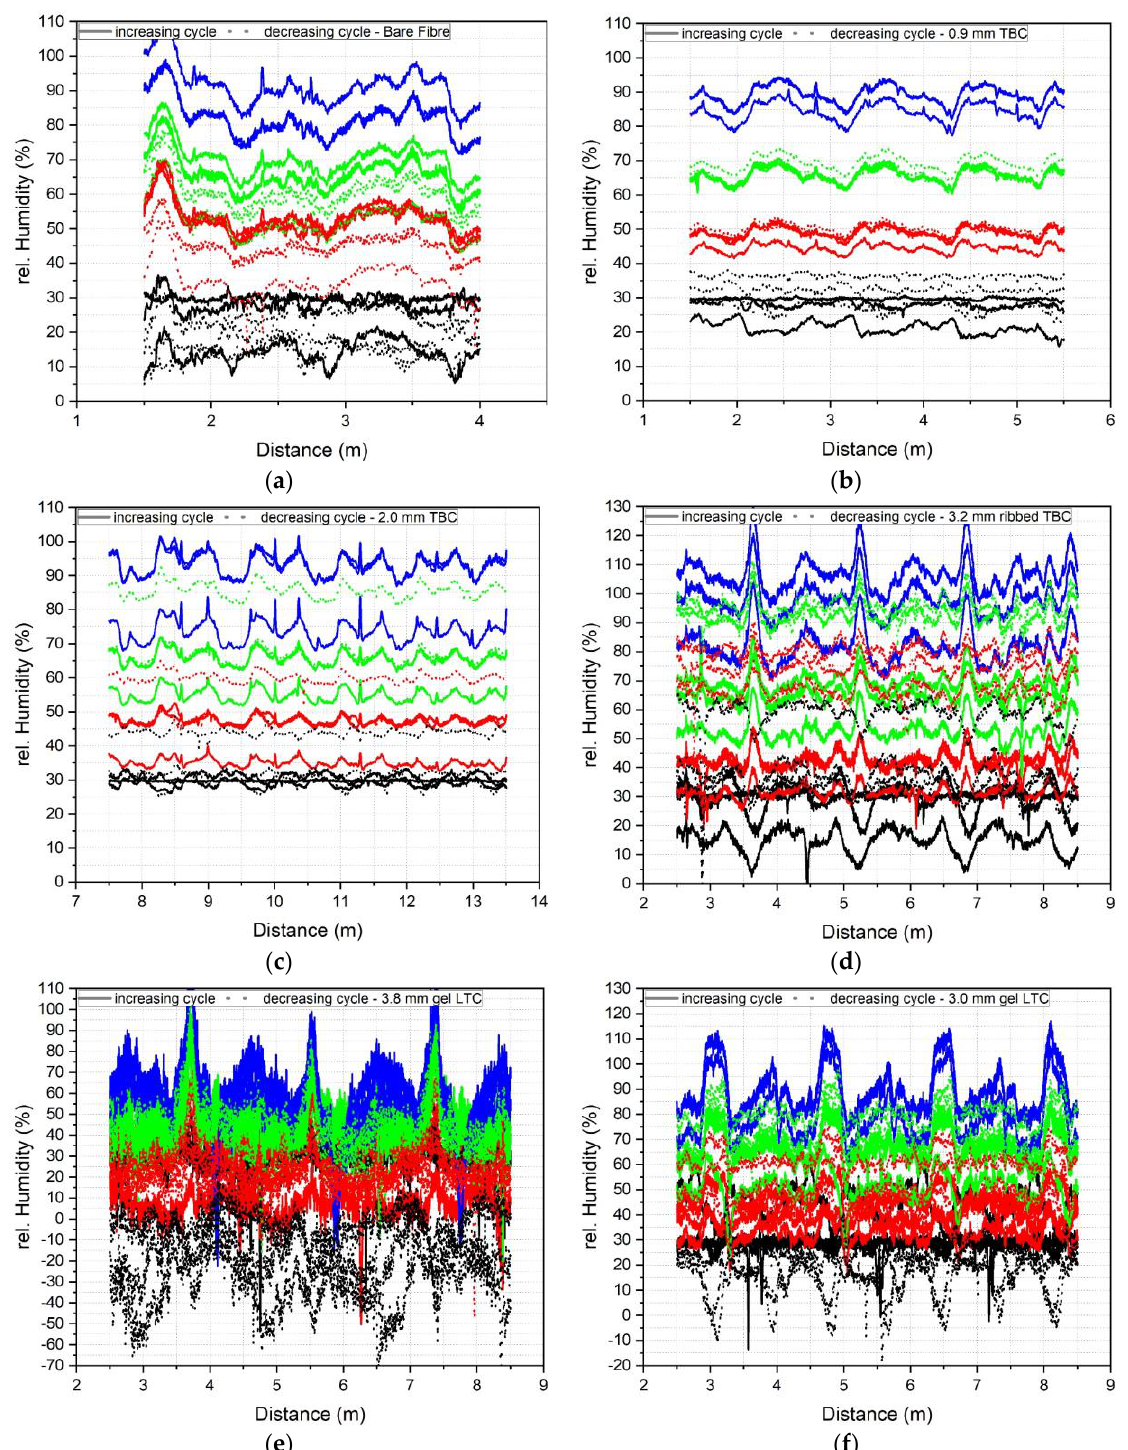
Figure A4. Humidity, spatial stability of ( a ) bare fibre cable ( b ) 900 μ m tight buffered cable ( c ) 2.0 mm black tight buffered cable ( d ) 3.2 mm blue ribbed tight buffered cable ( e ) 3.8 mm-2 core loose tube (gel filled) cable ( f ) 3.0 mm-1 core black loose tube (air filled) cable.